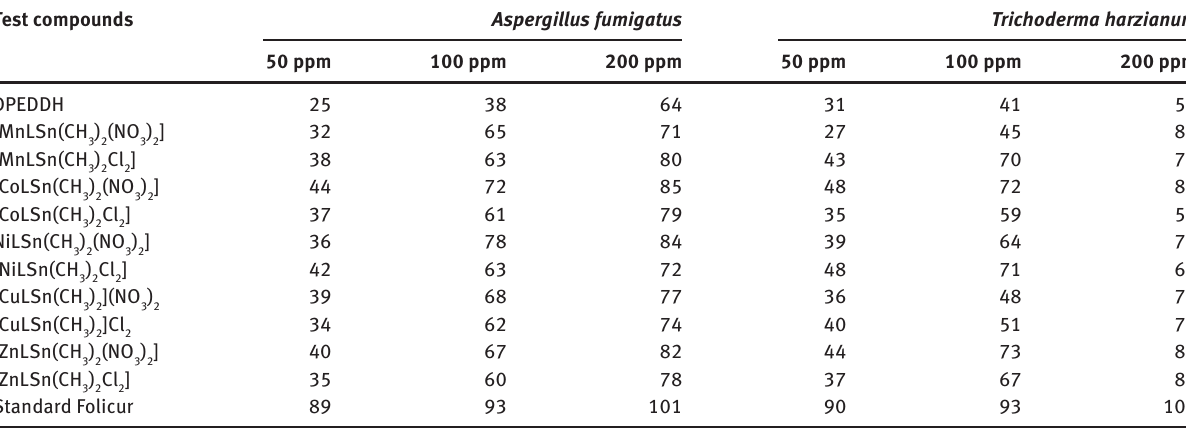
Table 1: Antifungal activity in μ g/mL of the complexes and starting materials after 5 days at 25 ± 2 ° C. Test